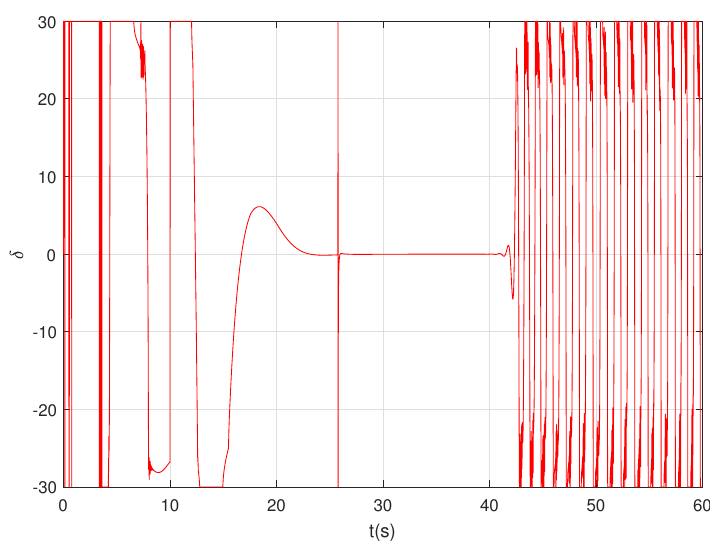
Figure 13. Angle of the air